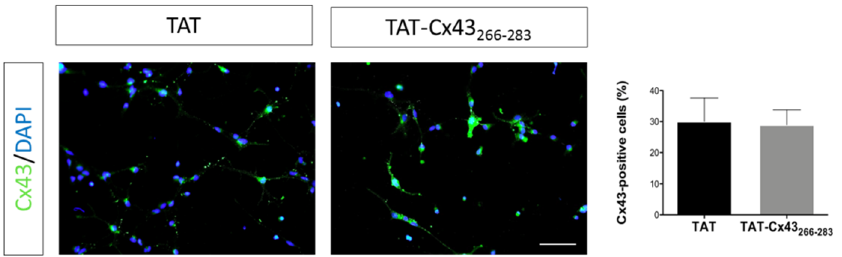
Figure A1. Full Western blots and replicates analyzed in different conditions. ( A ) Full Western blots and replicates analyzed in Figure 3C. ( B ) Full Western blots and replicates analyzed in Figure 5C,D. ( C ) Full Western blots and replicates analyzed in Figure 6A. ( D ) Full Western blots and replicates analyzed in Figure 6D.